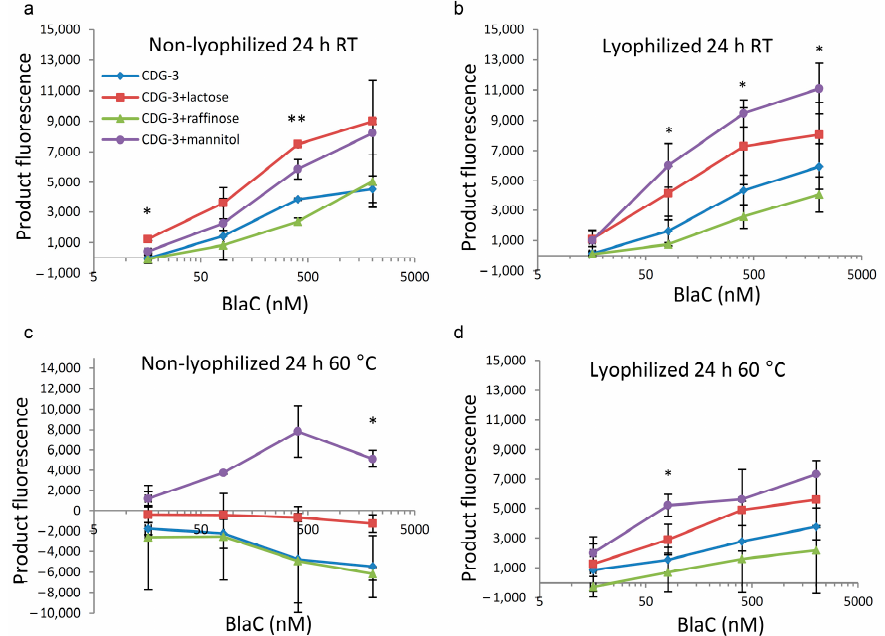
Figure 4. Use of lactose and mannitol as lyophilization excipients protects CDG-3 from degradation at elevated temperatures. For each data point, the difference between fluorescent signal and background fluorescence of CDG-3 is shown (30 min of exposure to BlaC). ( a )—exposed to room temperature for 24 h in non-lyophilized form (* p < 0.01 in the comparison: CDG-3 vs. lactose; lactose vs. raffinose; p = 0.025 in the comparison of lactose vs. mannitol. ** p < 0.01 in the comparisons: CDG-3 vs. lactose, lactose vs. raffinose, raffinose vs. mannitol; p < 0.05 in: CDG-3 vs. raffinose and mannitol, lactose vs. mannitol); ( b )—exposed to room temperature for 24 h in lyophilized form (* p < 0.05 in the comparison of raffinose vs. mannitol); ( c )—exposed to 60 ◦ C for 24 h in non-lyophilized form; * p = 0.01 in comparisons: CDG-3 vs. mannitol and p = 0.008 in the comparison of raffinose vs. mannitol); ( d )—exposed to 60 ◦ C for 24 h in lyophilized form (* p < 0.036 in the comparison of raffinose vs. mannitol).